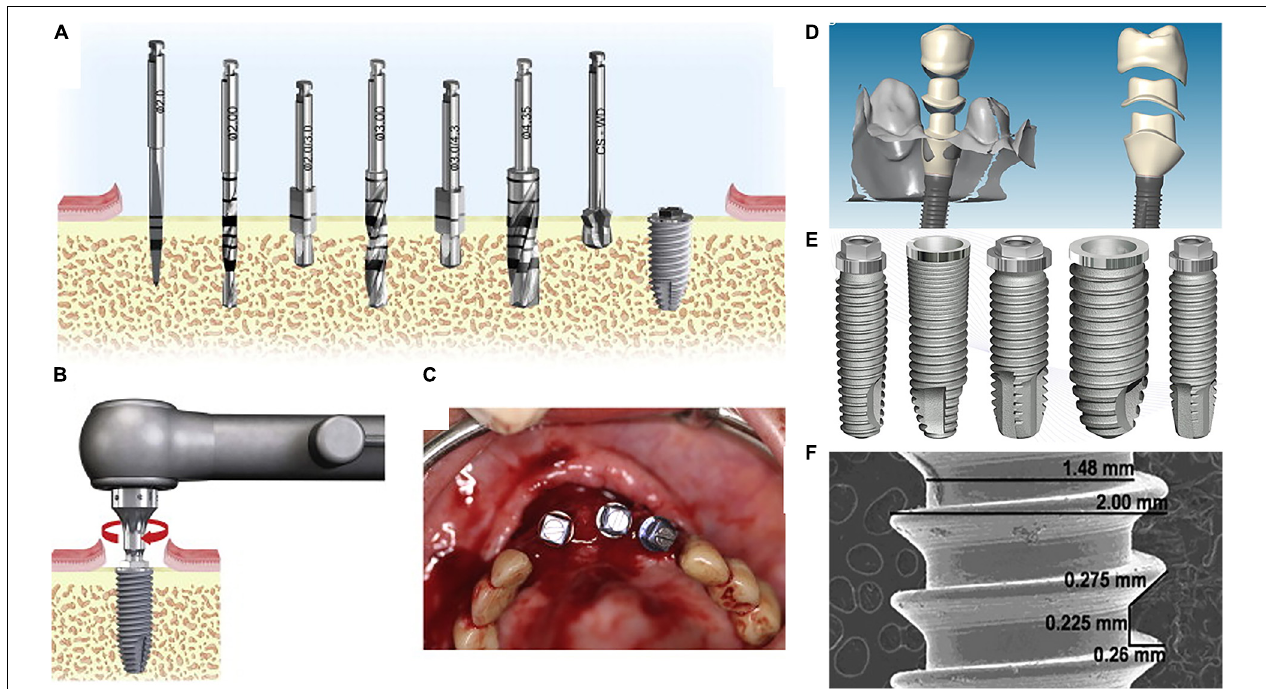
FIGURE 1 | The procedure of the dental implant process: (A) selecting and drilling the appropriate implant diameter, (B,C) inserting the dental implant into the bone, (D) prosthesis (ceramic or metal-ceramic) attachment, (E,F) examples of dental implants (Nelson et al., 2013).